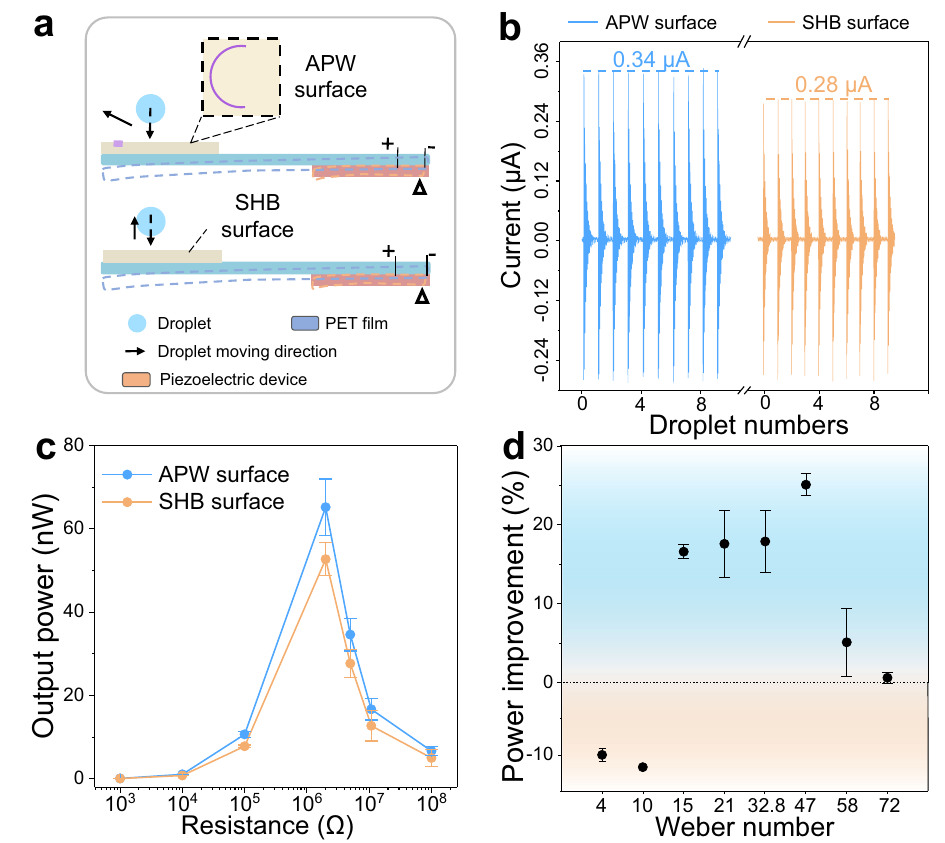
Fig. 4 Enhancing the hydropower collection ef fi ciency. a Schematic diagram of the piezoelectric devices equipped with APW (up) or SHB (down) surfaces. b Comparison of the current of ten droplets impacting on the piezoelectric devices equipped with APW or SHB surfaces. c Different output powers with different resistances. We = 47. d Power improvement (( P -APW − P -SHB )/ P -SHB ) under different Weber numbers. The external resistance is 2 M Ω . The error bars of the data in c , d are obtained from the s.d. of 7 independent